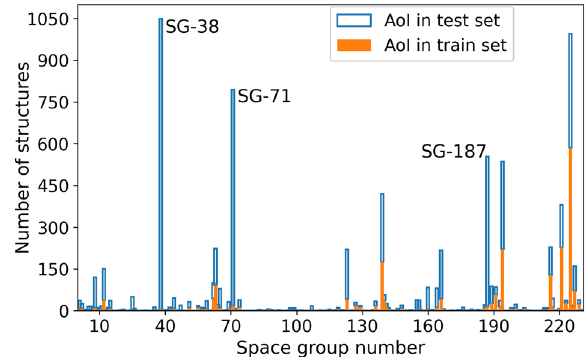
Fig. 4 Number of structures as a function of space group number. For reference, the lattice type for a given interval of SG numbers is as follows: [1,2] triclinic, [3,15] monoclinic, [16,74] orthorhombic, [75,142] tetragonal, [143,167] trigonal, [168,194] hexagonal, and [195,230]